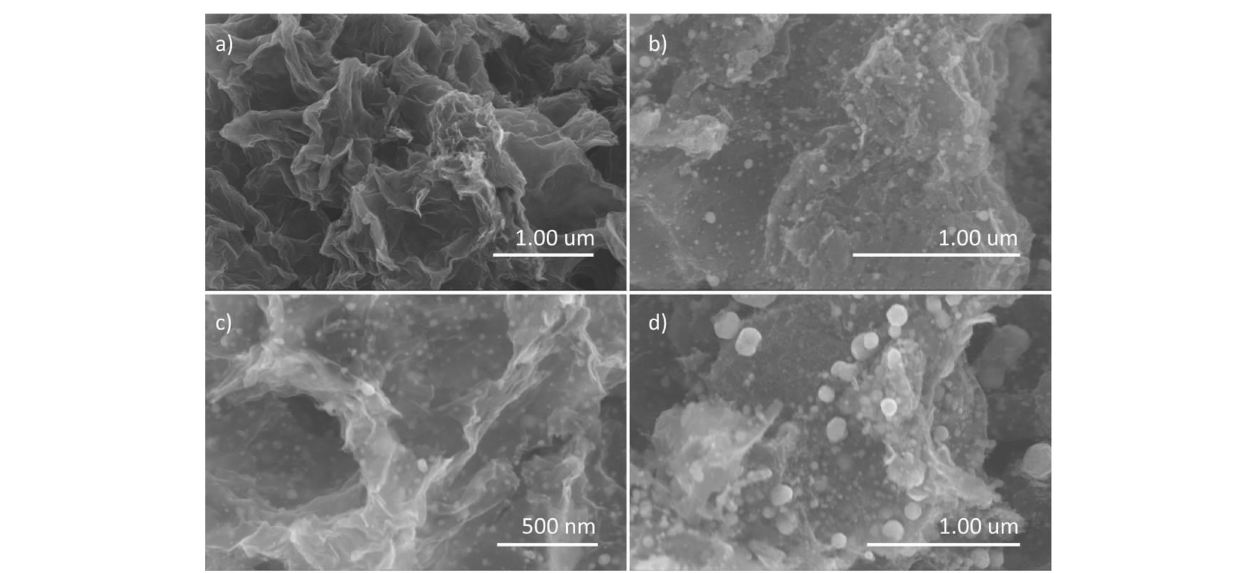
FIGURE 1 | SEM images of (a) CGP, (b) CoP-CGP1, (c) CoP-CGP2, and (d) CoP-CGP3.